Question: According to this chart, does the measure grow or shrink?
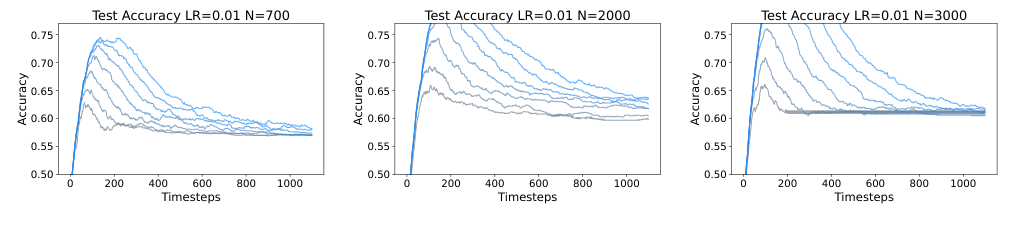
Answer: increasing